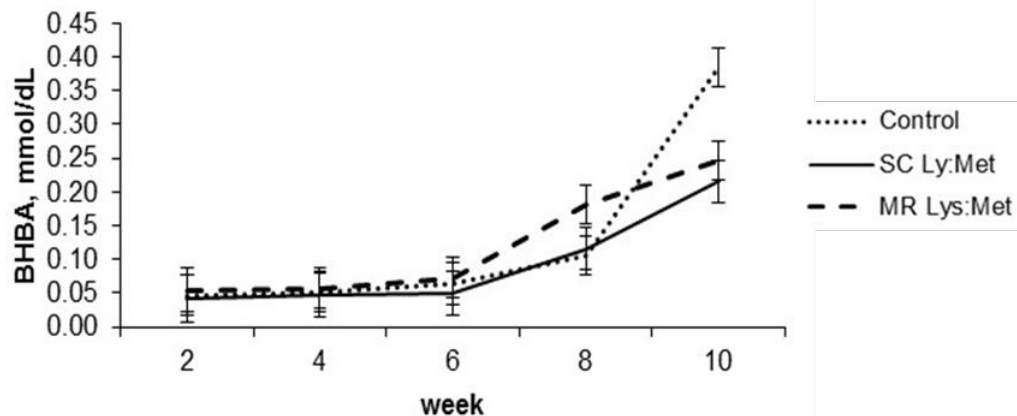
Figure 5. β-Hydroxybutyrate (BHBA) concentration in dairy calves with or without lysine and methionine supplementation in starter concentrate or milk replacer. Error bars indicate standard error of the mean.